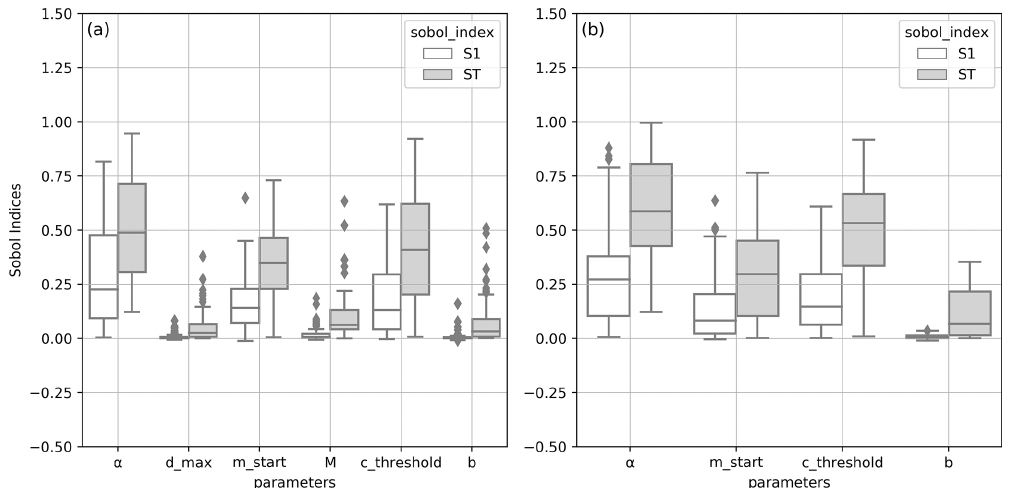
Figure 14. Distribution of first- (“ S 1”) and total-order (“ST”) Sobol indices of parameters based on C 2M variance over volumes: (a, c) in irrigation and (b, d) in non-irrigation reservoirs.